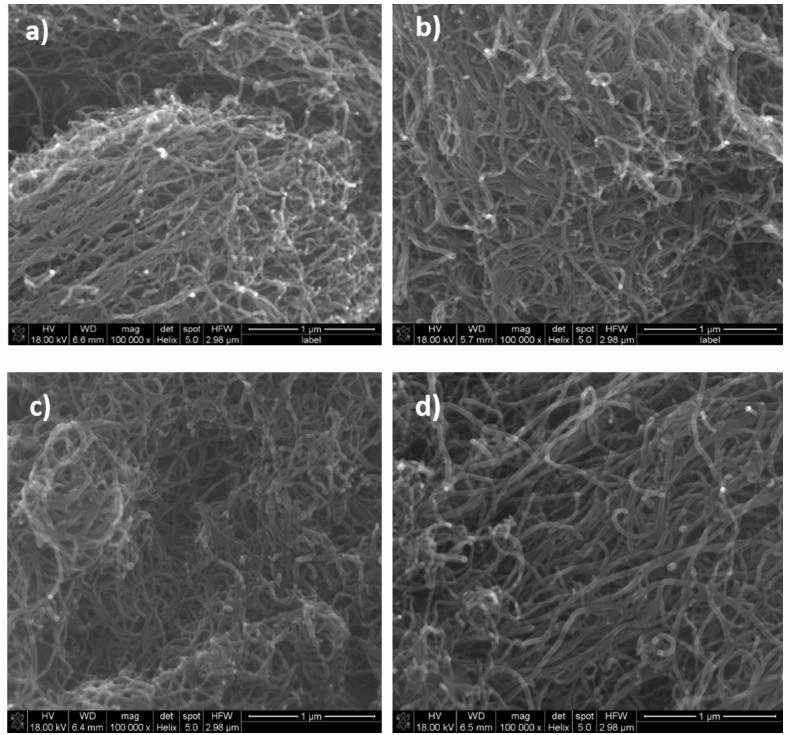
Figure 2. The SEM images of MWCNTs: native ( a ) and brominated for 7 ( b ), 10 ( c ) and 14 days ( d ).